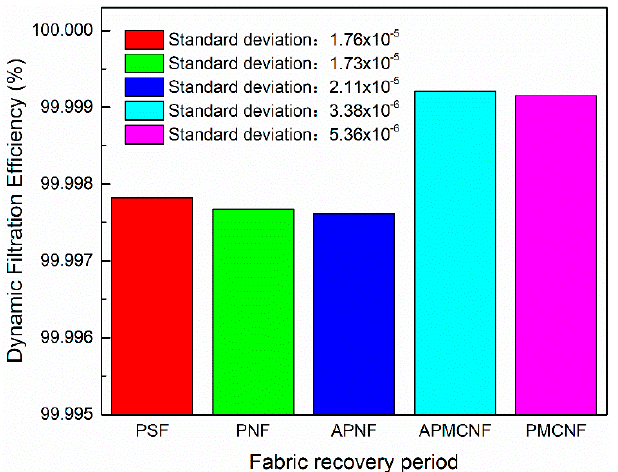
Figure 14. The dynamic filtration efficiencies of the five filter media during the fabric recovery period.